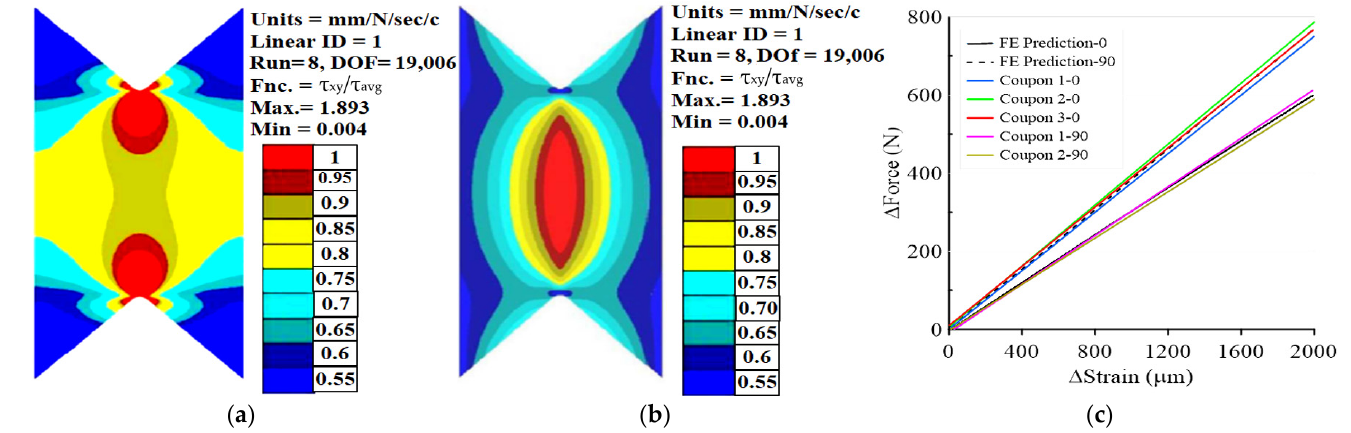
Figure 23. ( a , b ) Normalized shear stress, as obtained by the FEA at p = 8, for 0° and 90° orientations, respectively; ( c ) computed compared to experimental force vs. shear strain.